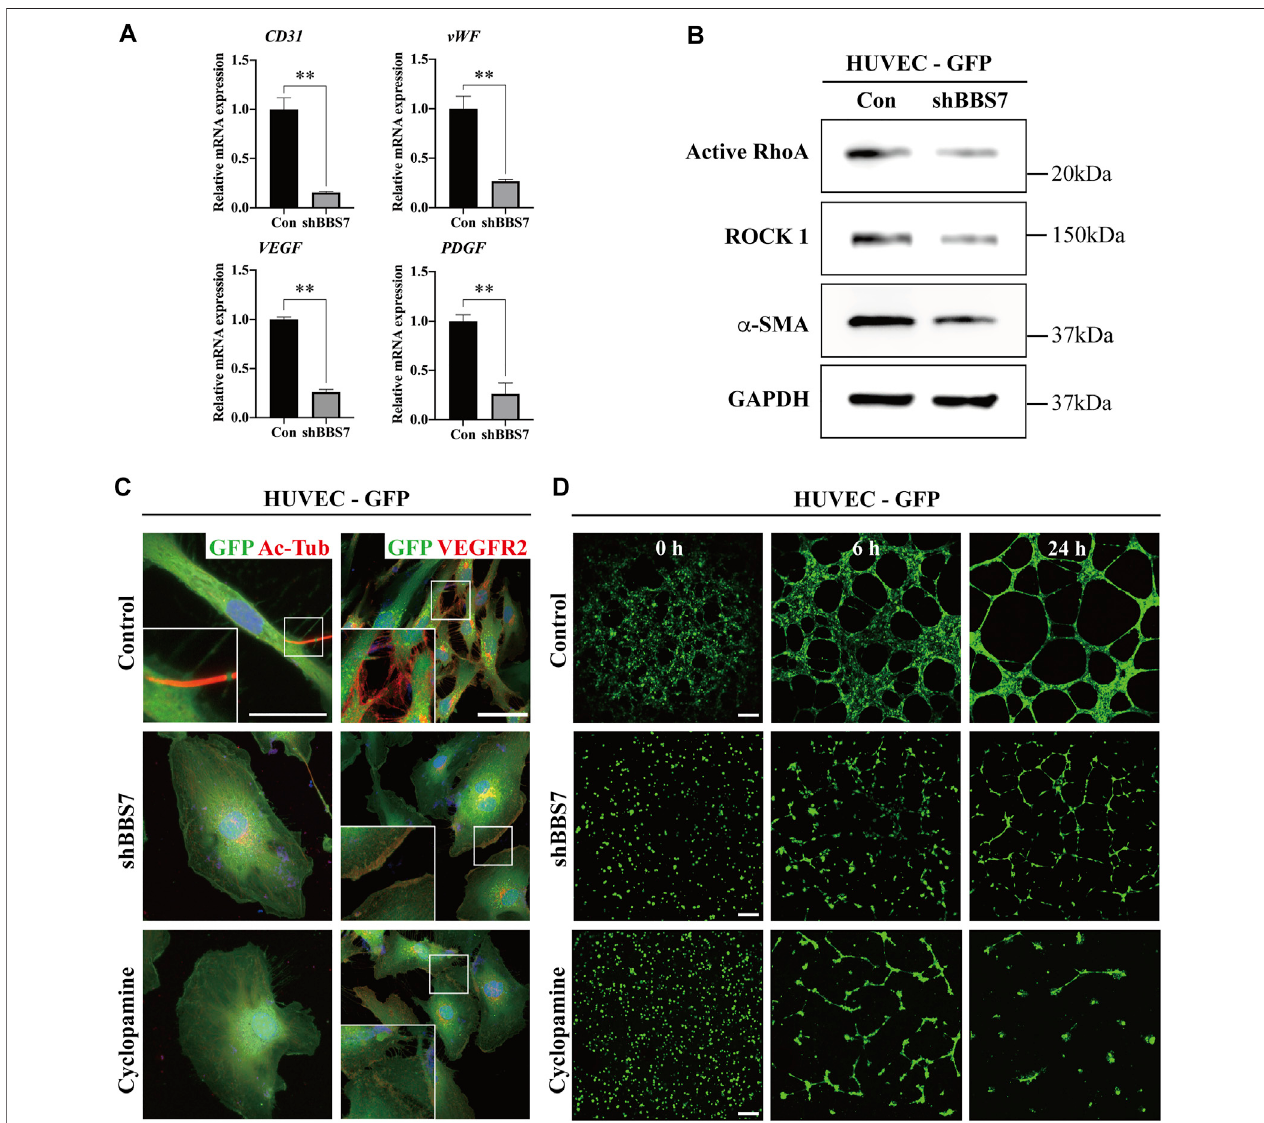
FIGURE 4 | Effect of BBS7 knockdown on HUVECs. (A) Relative mRNA expression on angiogenesis markers. Compared to the control group, the expression of CD31 , vWF , VEGF , and PDGF is signi fi cantly decreased in the shBBS7 group. (B) The protein expression of migration markers (active RhoA and ROCK 1) and endothelialmarker( α -SMA) issigni fi cantlydecreasedintheshBBS7 group. (C) Ac-Tub – labeled primarycilia(red) areonlyobservedinthecontrolgroup. Theexpression of VEGFR2 is signi fi cantly decreased in shBBS7 and cyclopamine groups compared to the control group. (D) GFP-labeled HUVECs are cultured for 24 h in a 96- well plate coated with Matrigel ® . Cells of the control group initially attached at 0 h, then migrated individually over the next 6 h and formed tubule-like structures, which matured by 24 h. Cells of the shBBS7 group initially attached at 0 h, then just a few tubule-like structures at 6 h, and failed tubule formation at 24 h. Cyclopamine group failed to form a junction and network at 6 and 24 h. Con: control group; scale bars; C. left column, 25 μ m; right column, 50 μ m. D, 400 μ m, Ac-Tub: acetylated-tubulin; VEGFR2: vascular endothelial growth factor receptor 2.